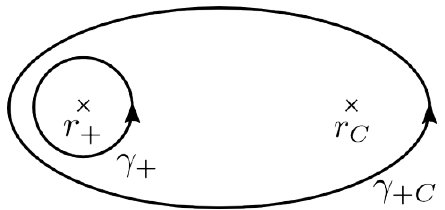
Figure 4 . Example of local ( (cid:13) + ) and composite ( (cid:13) + C ) monodromy paths in the complex- r plane around the singular points r = r + and r C